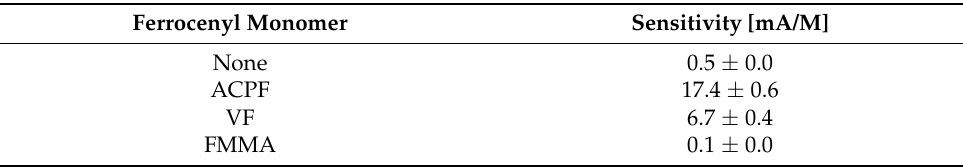
Table 1. Sensitivity to VCM or TEIC at each electrode.